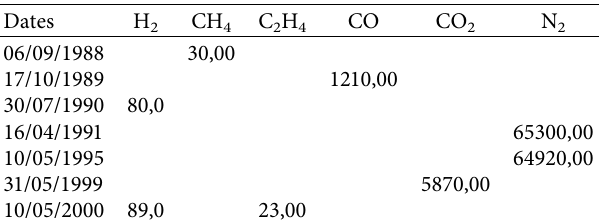
Table 2: Simulated missing values of transformer